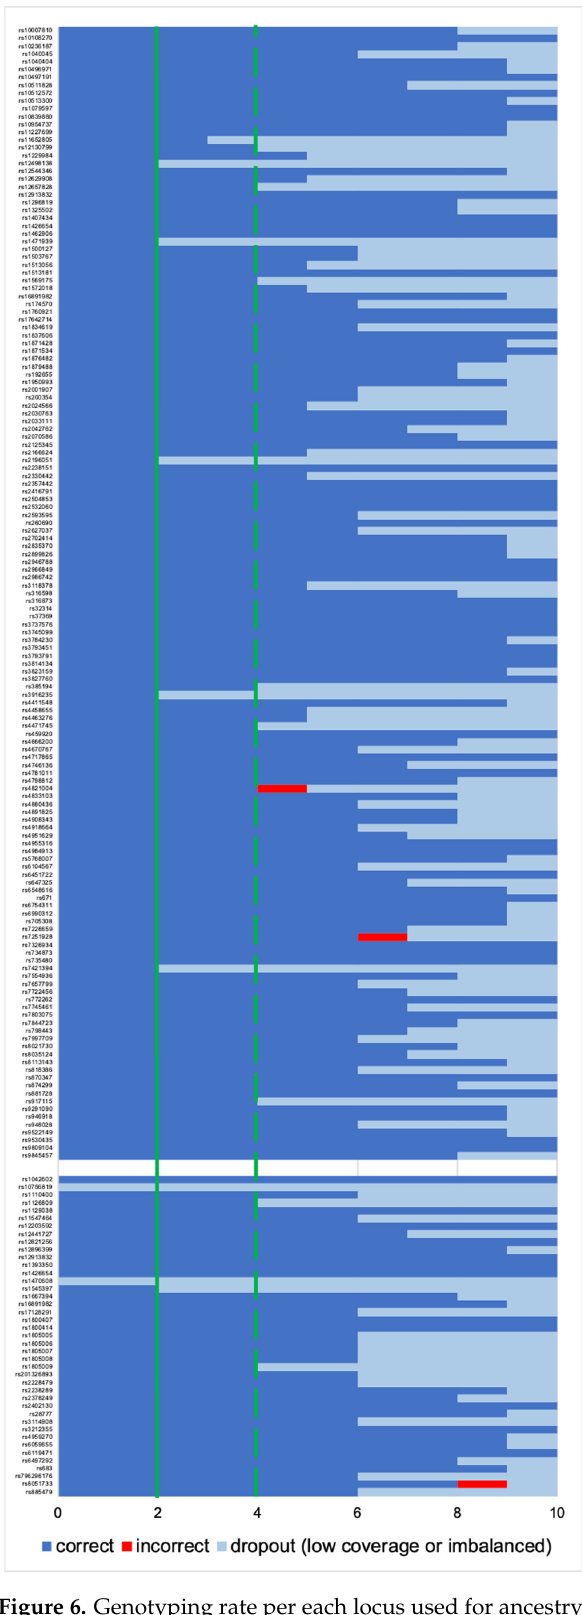
Figure 6. Genotyping rate per each locus used for ancestry prediction (max. 145 SNPs, upper part) and phenotype prediction (max. 41 SNPs, lower part). The x-axis shows the number of single cells with correct, incorrect or no genotype. Solid line: “basic” profile; dotted line: “conservative”